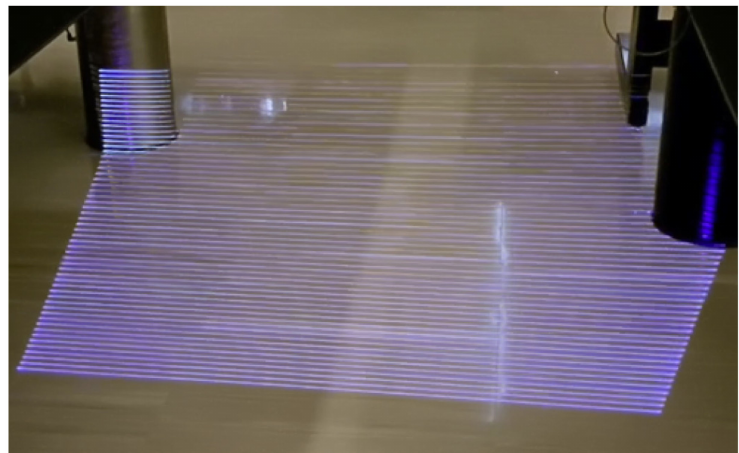
Figure 5. Laser galvanometer simulating sanitizing the